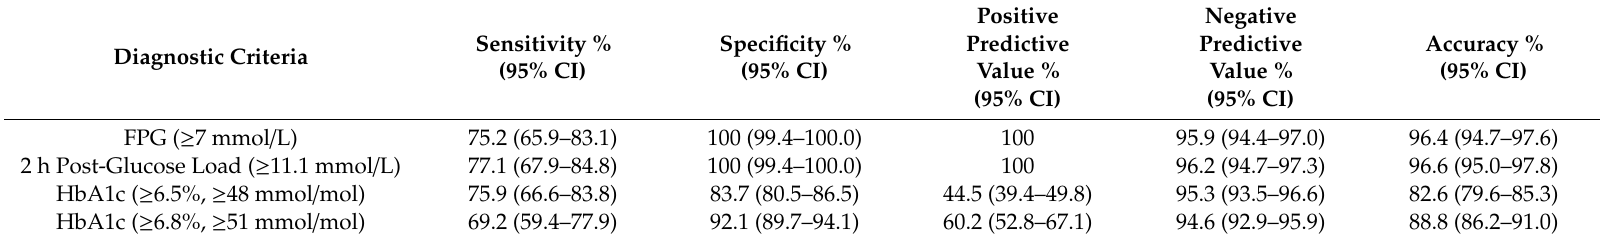
Table 3. Diagnostic performances of FPG, 2 h post-glucose load and HbA1c to diagnose diabetes, using the WHO criteria as the gold